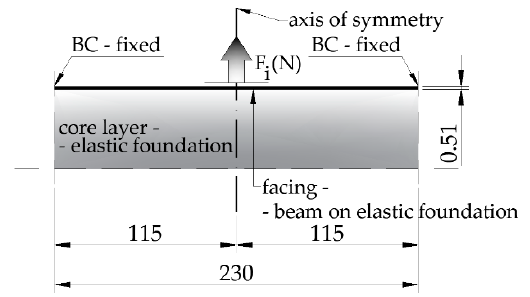
Figure 9. Geometrical parameters (in mm) of the aluminum blind rivet with three clamping arms.